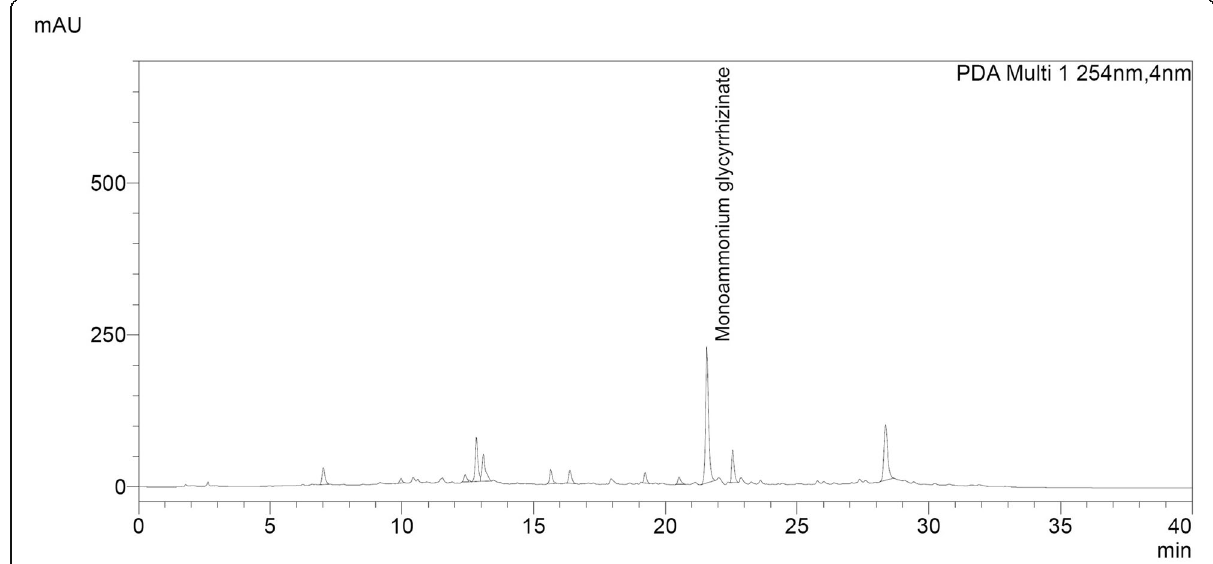
Fig. 3 HPLC chromatogram of Yashtimadhu dry extract